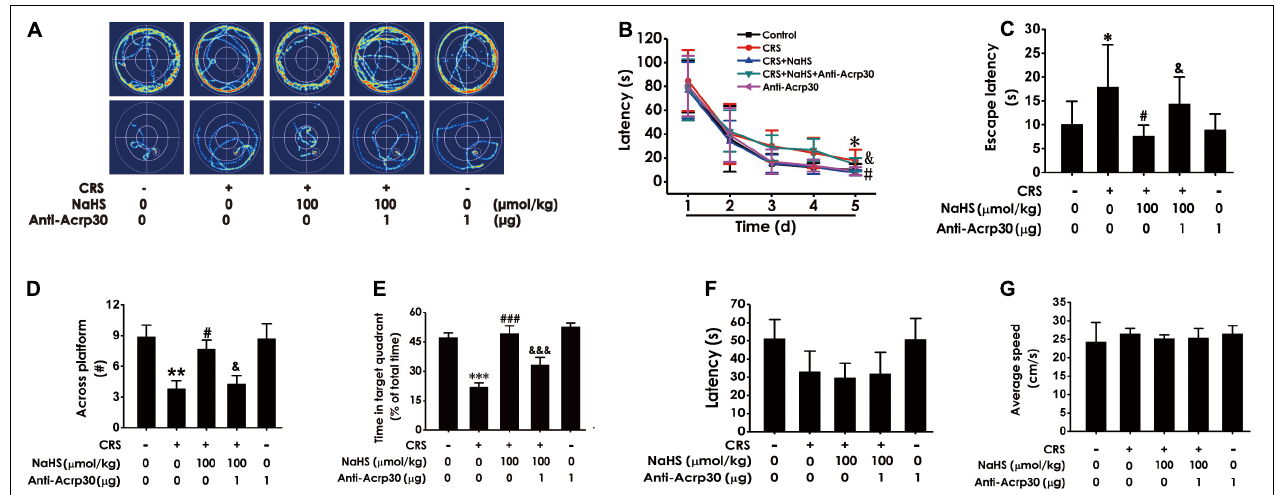
FIGURE 4 | Effects of Anti-Acrp30 on NaHS-ameliorated cognitive dysfunction in CRS-exposed rats in Morris Water Maze test. Rats were co-treated with NaHS (100 µ mol/kg/day, i.p.) and CRS (6 h/day) for 3 weeks, and then co-administrated with Anti-Acrp30 (1 µ g/day, i.c.v.) for further 1 week. The route of rats in 1st and 5th in training phase (A) , the latency period during 5 days (B) , and the escape latency in 5th in the acquisition phase (C) were respectively recorded. The time of crossing the platform (D) and the proportionality of swimming time in target quadrant (E) in the probe trail were respectively recorded. The latency period (F) and the average speed (G) to reach platform in the visible platform test of rats were respectively recorded. All values are expressed as mean ± SEM ( n = 6–7/group) in the captions of morris water maze test. * P < 0.05, ** P < 0.01, *** P < 0.001 vs. control group; # P < 0.05, ### P < 0.001 vs. CRS-exposed alone group; & P < 0.05, &&& P < 0.001 vs. co-treatment with NaHS and CRS